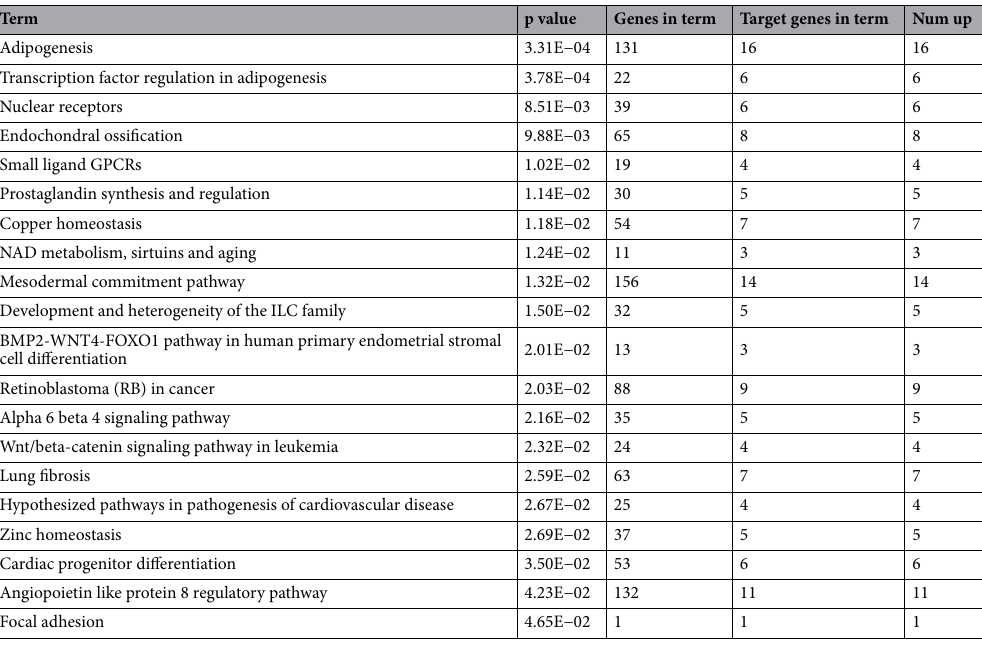
Table 2. Pathway analysis of upregulated